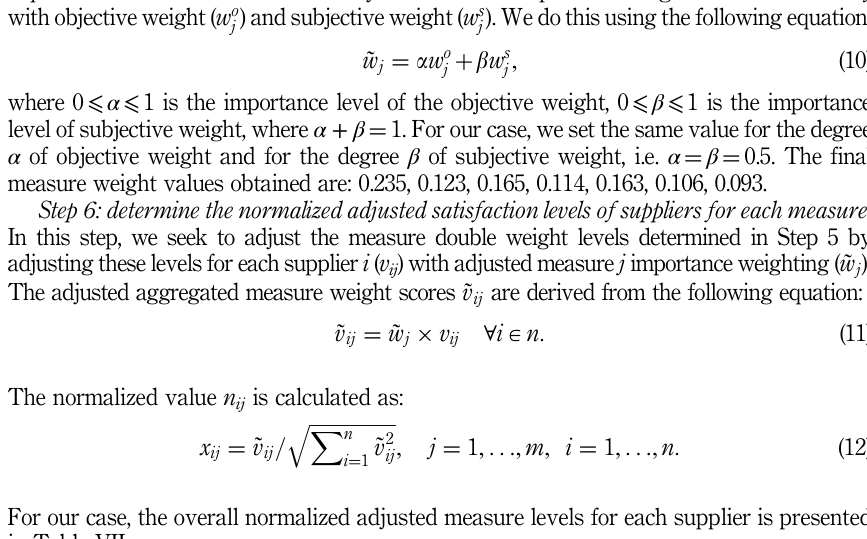
Step 5: determine the overall final measure weight level by adjusting for double